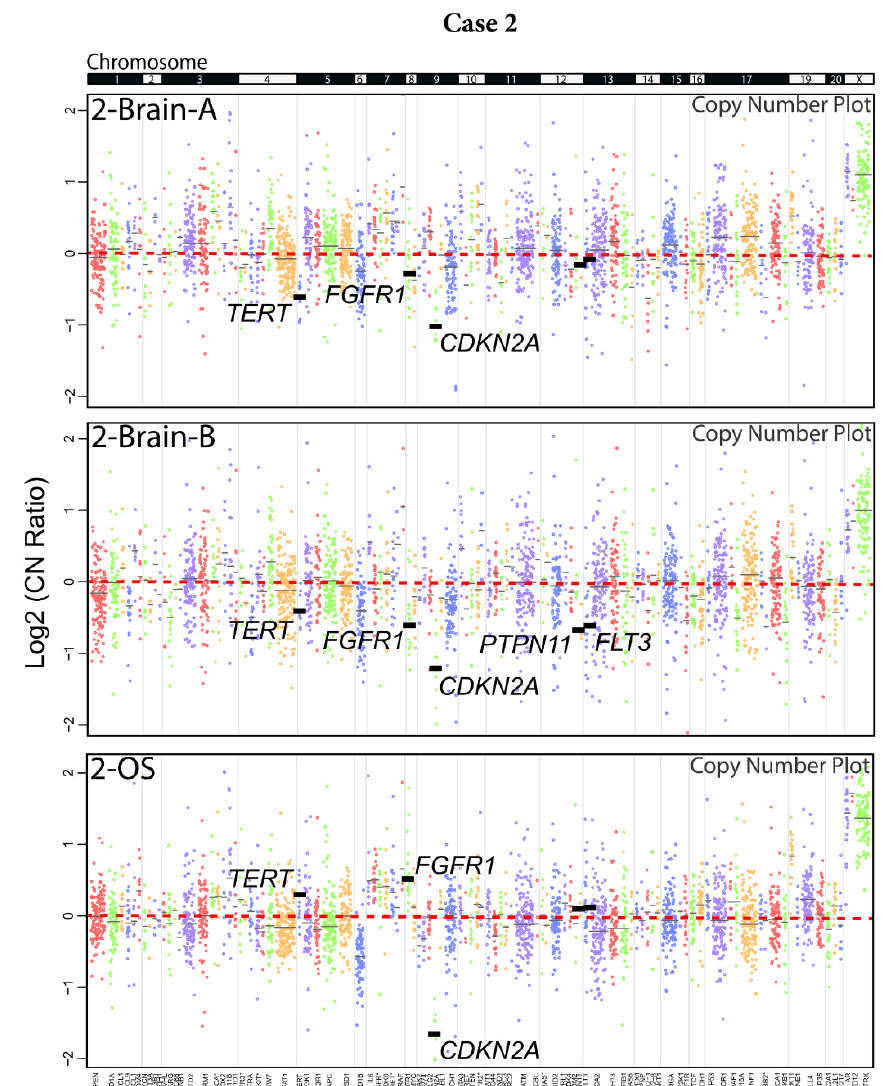
Figure 4. Copy number plots of matched brain tissue and vitreous liquid biopsy samples for Case 2. Copy number plots for each sample are shown as log2 copy number ratio (amplicon-level ratio between read counts in the tumor sample and read counts in a composite of normal samples, normalized for sequencing depth and GC content). Dots represent individual amplicon log 2 copy number ratios. Dots of the same color represent a gene, and black horizontal bars represent average gene-level log2 copy number ratio estimates (coverage-weighted). Genes are listed at the bottom in chromosome order and chromosomes are separated by gray lines and marked at the top. Genes marked with * have two groups of amplicons with different colors covering them. Altered/relevant genes are highlighted with thick, black lines for gene-level log2 copy number